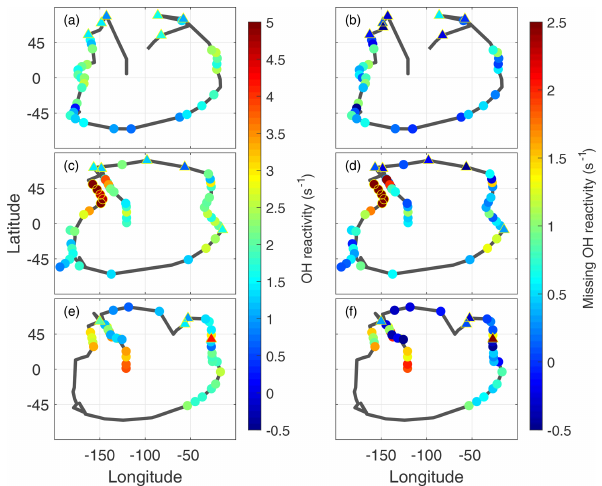
Figure 8. Missing OH reactivity averaged per-dip versus latitude over the Pacific Ocean (blue) and the Atlantic Ocean